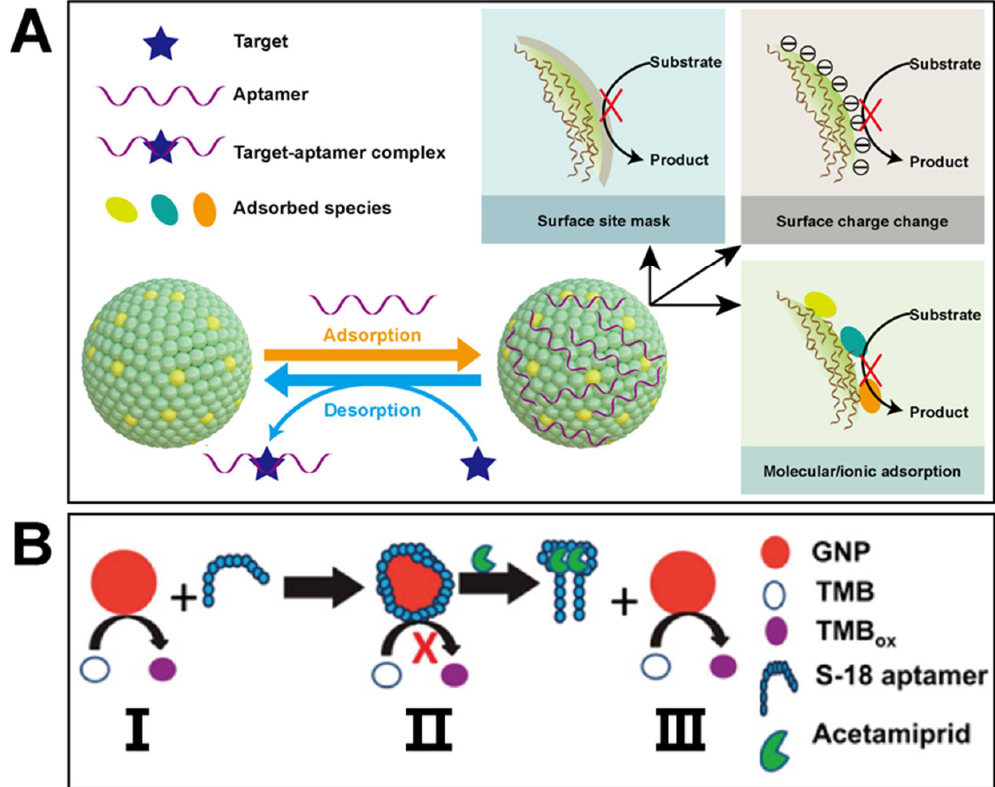
Figure 7. ( A ) presents potential impacts of aptamers on catalytic performance of nanozymes. ( B ) shows principle of detecting acetamiprid using a gold-based nanozyme and a specific aptamer (Reprinted with permission from [122], Copyright 2014, American Chemical Society).